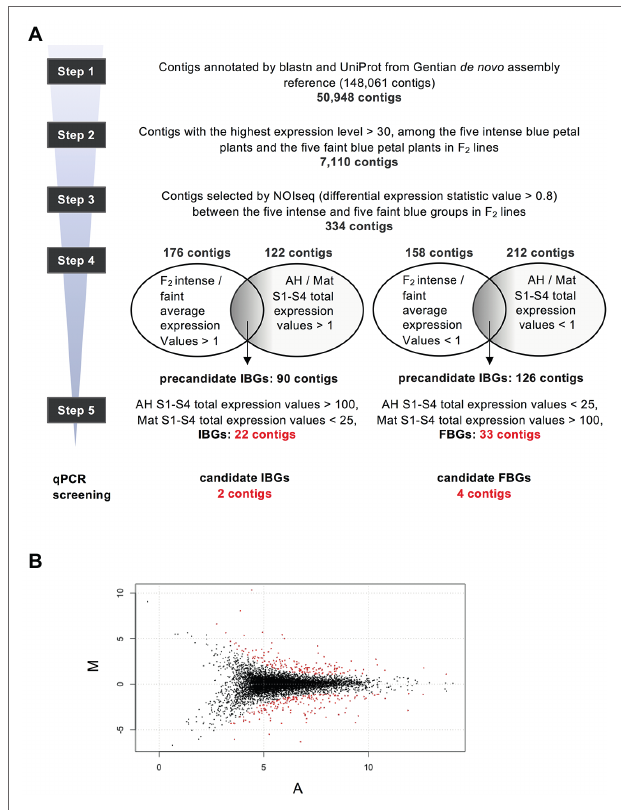
FIGURE 3 | Schematic of screening procedure of differential expression genes (DEGs). (A) Screening procedures of the DEGs. (B) MA-plot of 7,110 contigs in step 2. Red plots are 334 contigs of differentially expression genes selected from the probability of differential expression estimated using NOISeq analysis (Tarazona et al., 2015), with parameter q >